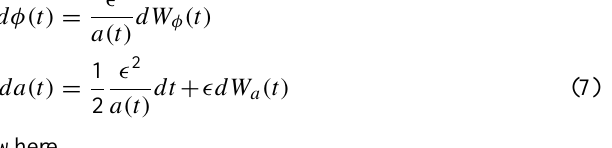
Fig. 3. (a) Diagram of the geometric explanation for the stochastically induced outward drift in a circular vortex. The flow is indicated by arrows. A circle representing the standard deviation of the stochastically perturbed particle is shown with the bisector of the circle formed bythetangentlinetothecircle. Itcanbeseenthatmorethanonehalfoftheareaofthecircleliesoutsideofthegreyregion. (b)as(a)but foramorecomplexpathwithvaryingcurvature.